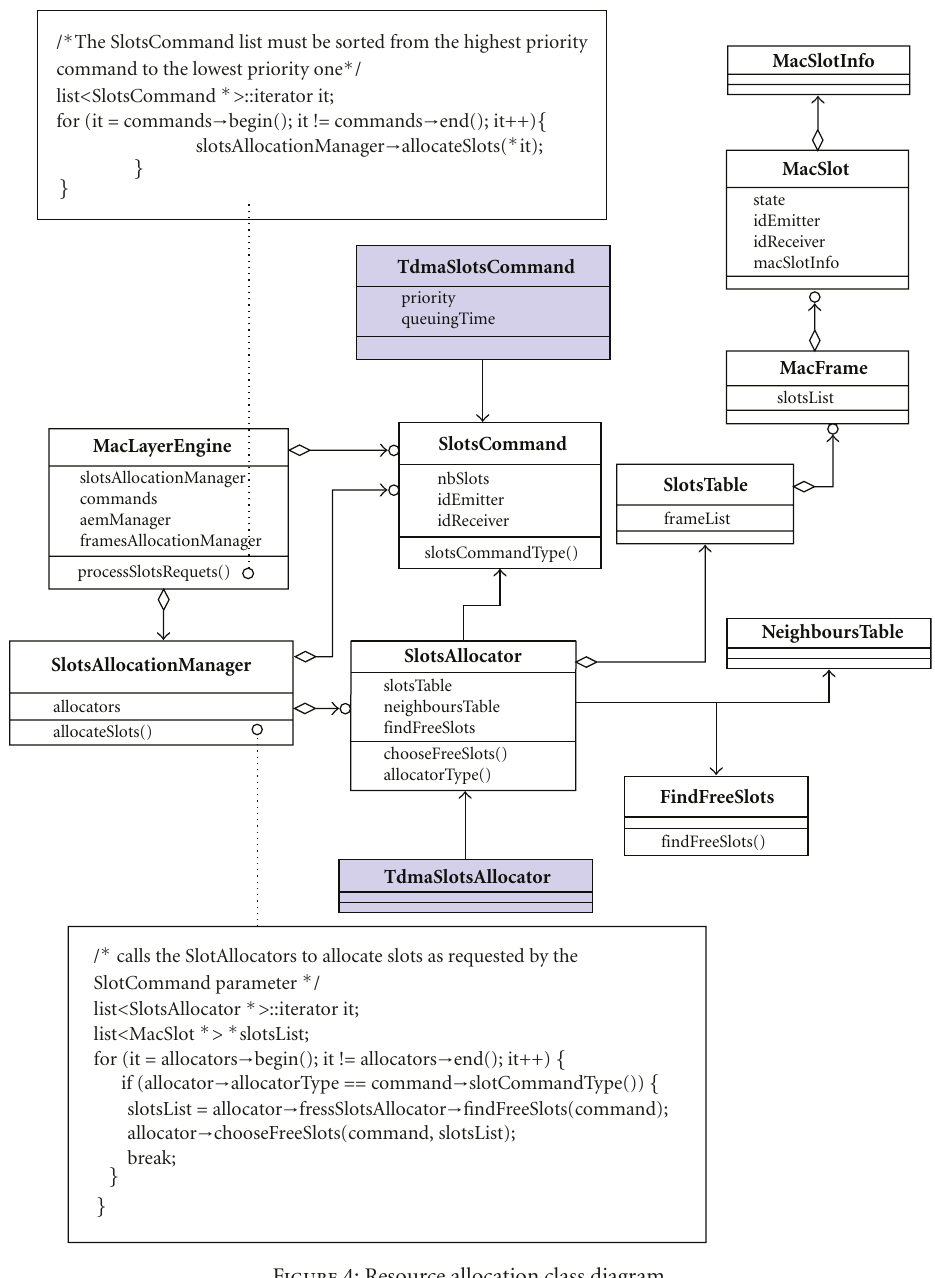
Figure 4: Resource allocation class